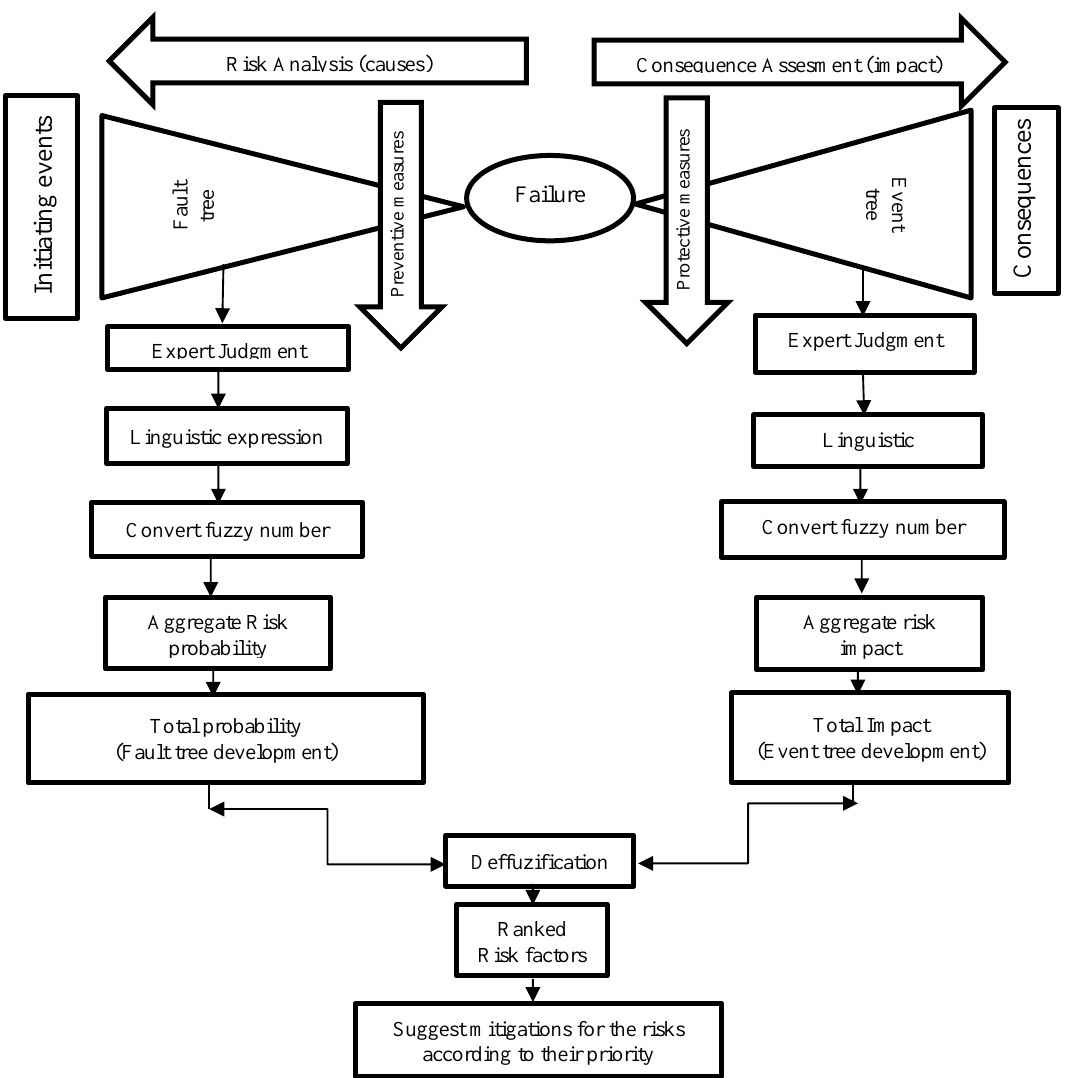
Figure 4. Implementation of Fuzzy Bow-Tie risk analysis